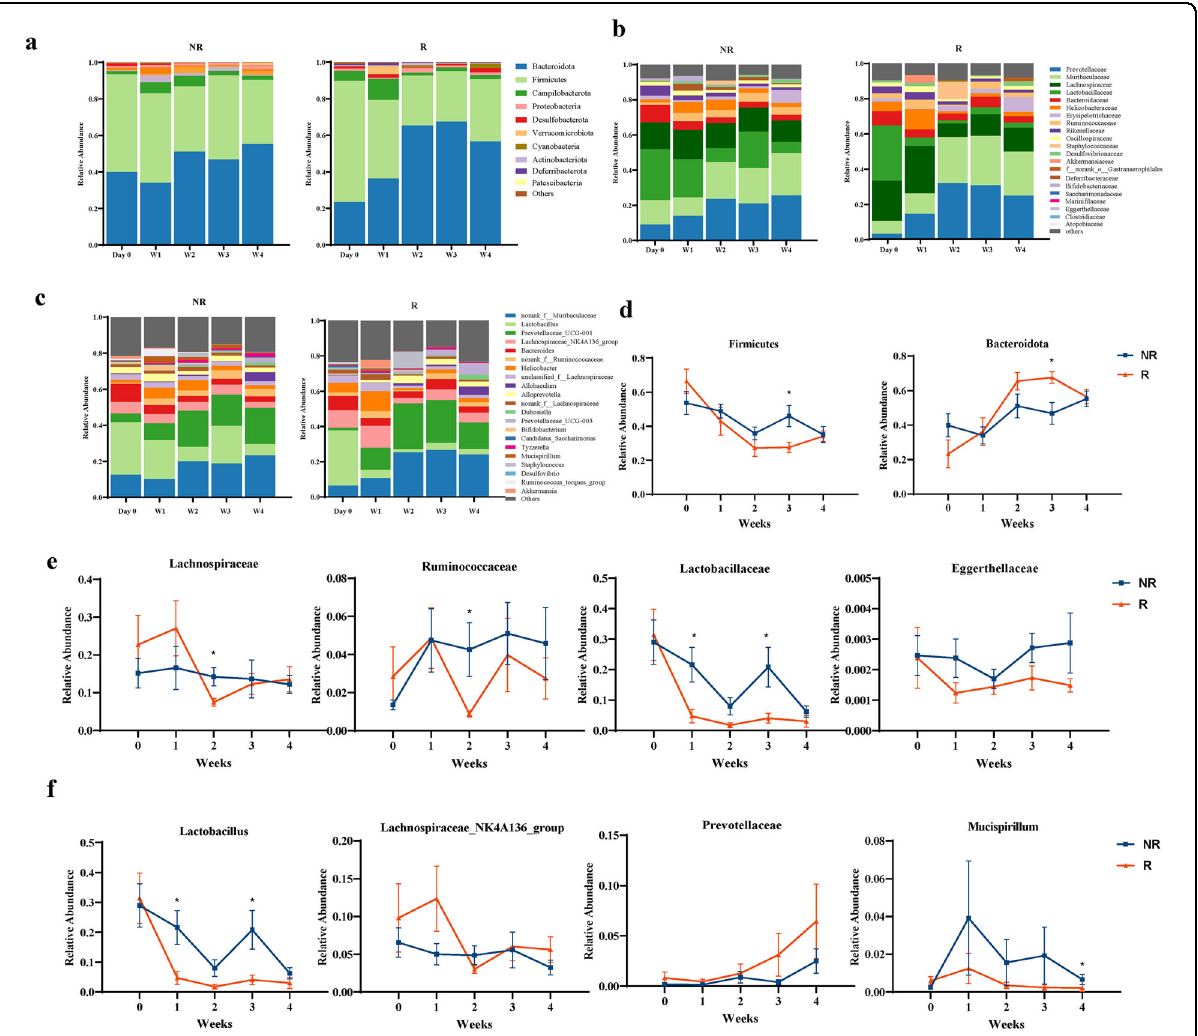
Fig. 3 Longitudinal changes in microbial composition between R and NR group. Stacked bar chart showing the longitudinal changes of the gut microbial composition in mice at the phylum ( a ), family ( b ) and genus ( c ) level between the two groups. Plots show the relative abundance of dominant bacterial phylum ( d ), family ( e ) and genus ( f ) at different stages. (* p < 0.05, Wilcoxon rank-sum